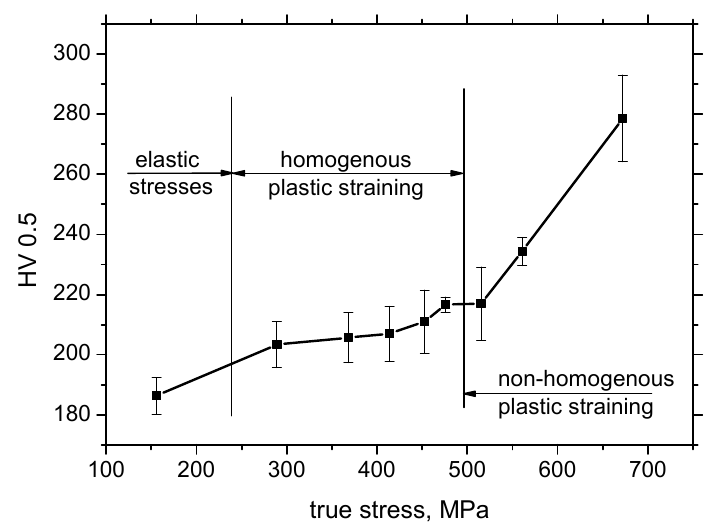
Figure 8. True stresses versus HV0.5, distance from the sample center 0 mm.